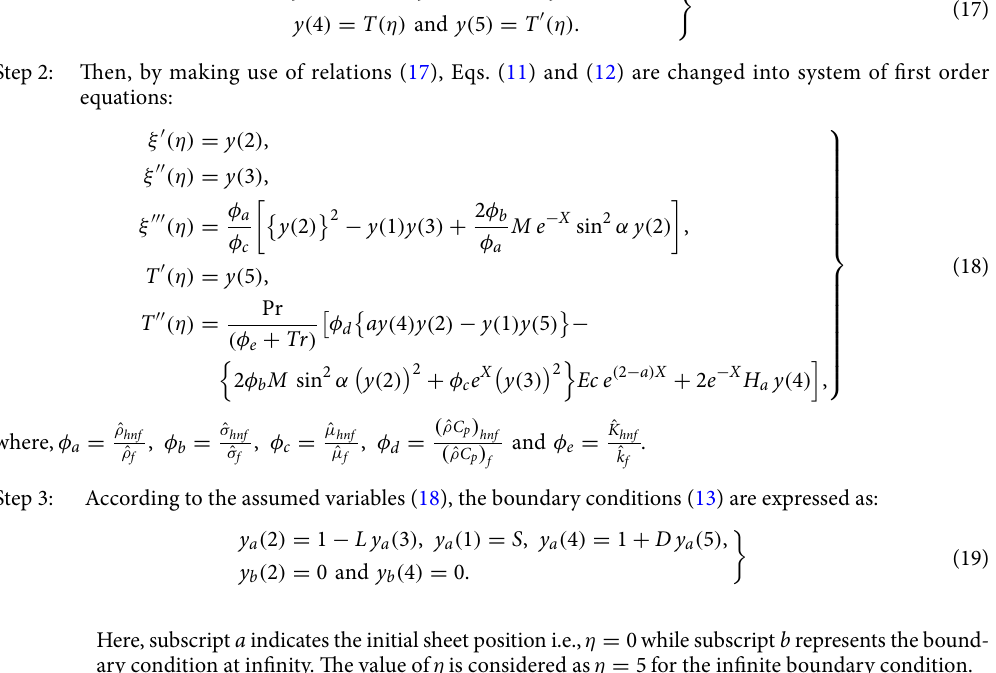
Validation of numerical findings and scheme. The obtained results and the employed numerical tech- nique have been validated by comparing the numerical entities of Nn x (local Nusselt number) with those of Wahid et al. 37 and have reported in tabular form. In pursuance, foremost the values of the magnetic parameter, aligned magnetic field angle, radiation parameter and Eckert number are respectively taken as M 0 and Ec 0 to convert the mathematical model comparable to Wahid et al. 37 . Further, the values of Nn x Tr = = are computed for the varying values of two different flow parameters S and D with the developed scheme of computed values are presented in Table 3, which disclose venerable agreement between the numerical results and executed numerical scheme. Thus, it reveals that the developed numerical scheme and the results of this paper are acceptable and